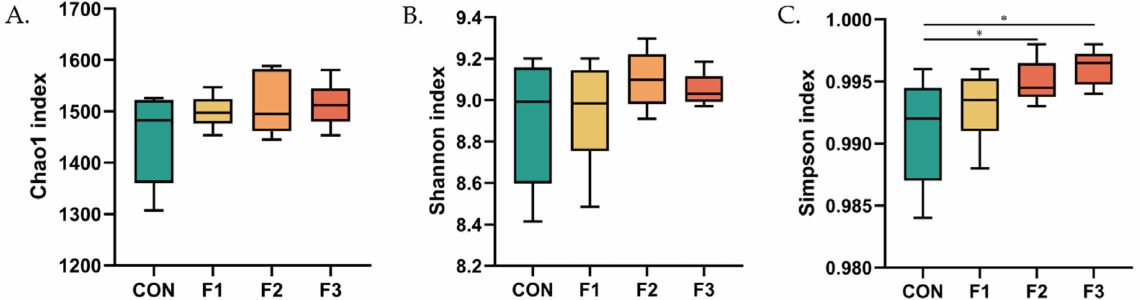
Figure 6. α -diversity index of gut microbiota. ( A ) Chao1 index; ( B ) Shannon index; ( C ) Simpson index. CON, basal diet; F1, basal diet + 0.1% fucoidan; F2, basal diet + 0.3% fucoidan; F3, basal diet + 0.5% fucoidan; * p <